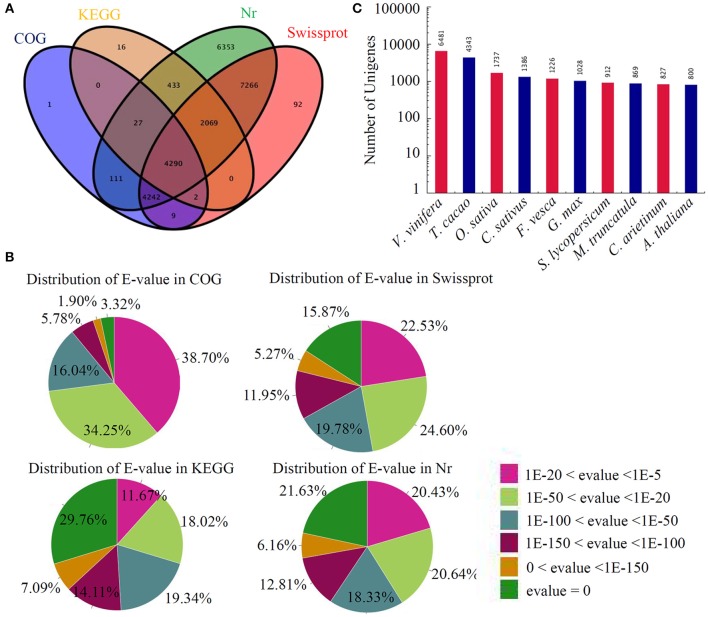
Annotation of assembled sugar apple unigenes. (A) In total, 24911 unigenes were annotated by different protein databases. The number of unigenes annotated by different databases, including Nr, Swissprot, COG, and KEG, were showed in a Venn diagram. (B) Distribution of E-value in Nr database. (C) Identification of the transcripts of other plant species homologous to the annotated unigenes of sugar apple.